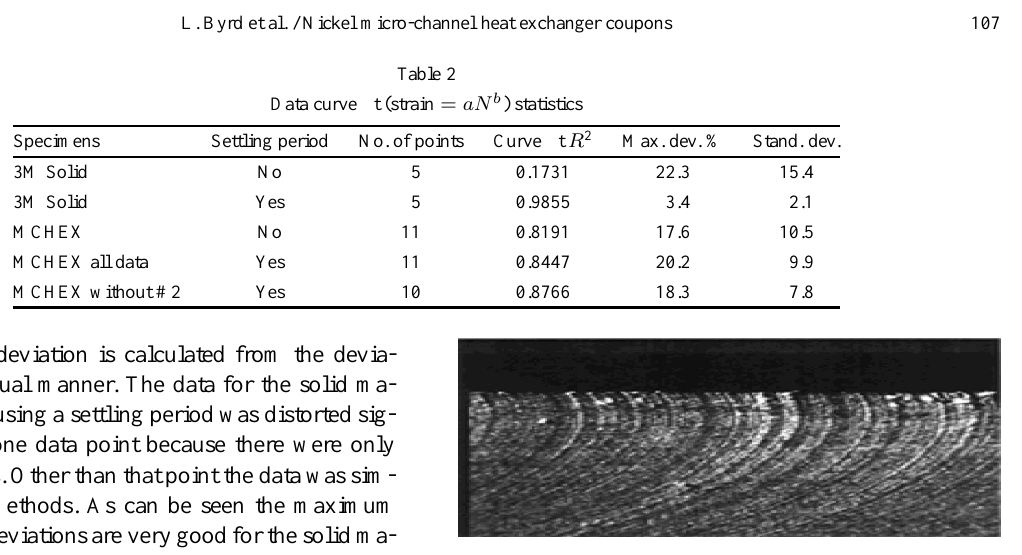
Fig. 6a. Typical bending fatigue failure in an aluminum specimen.